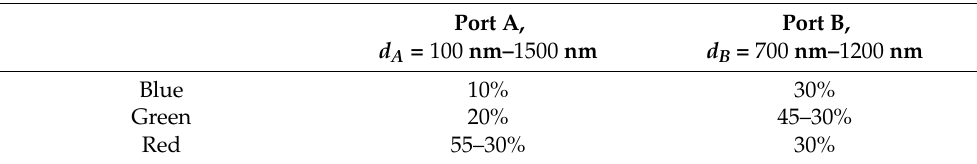
Table 1. Total transmittance measured for three different RGB colors at normal incidence, d ARC = 200 nm, d DT = 100nm, W ∗ = 440 nm, n 3 =